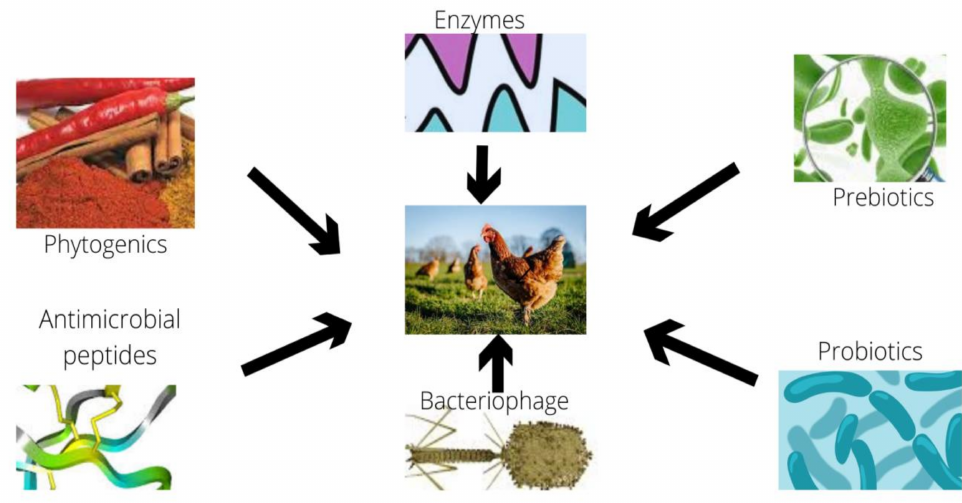
Figure 1. Example of some alternatives to antibiotics in poultry.